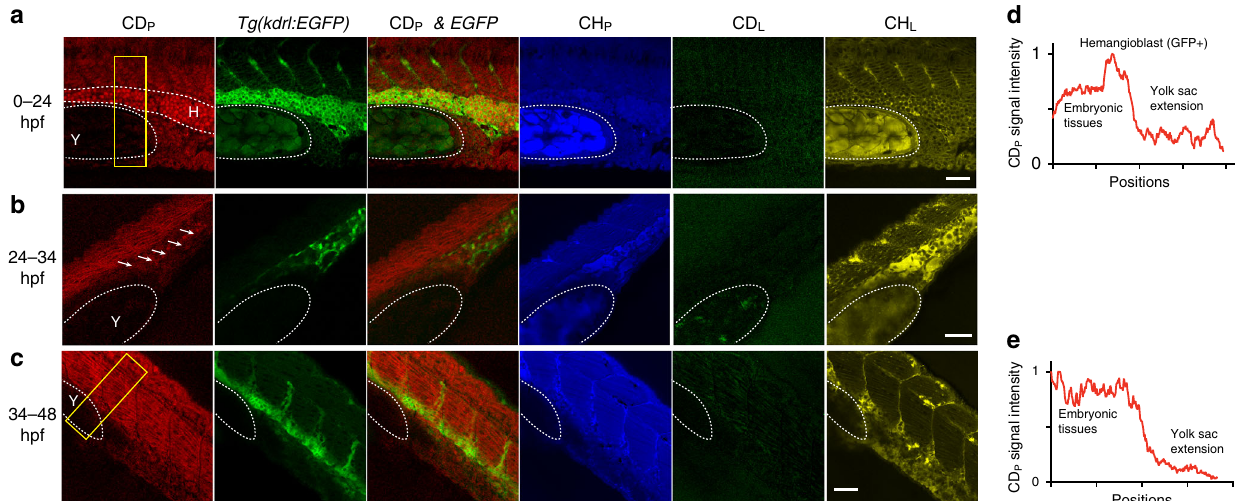
Fig. 8 DO-SRS microscopy, in combination with fl uorescent labeling, tracks lineage-speci fi c metabolism during zebra fi sh embryogenesis. a – c SRS microscopic signal and the colocalization with fl uorescence from Tg(kdrl::EGFP) reporter in zebra fi sh embryos that were incubated in egg solution containing 20% D 2 O from 0 to 24 hpf, from 24 to 34 hpf, or from 34 to 48 hpf. Dashed curves outline the yolk sac extension (labeled as Y) and the GFP- positive hemangioblast (labeled as H) that has strong CD P signal. Arrows point to the GFP-positive cells that are likely differentiating angioblasts in b . d , e Intensity pro fi les that quantify the CD P signal within the yellow rectangle for 0 – 24 and 34 – 48 hpf probing, respectively. x axis shows the position along the length of the box from top to bottom, and y axis shows the average intensity across the width of the box. Scale bar = 20 μ